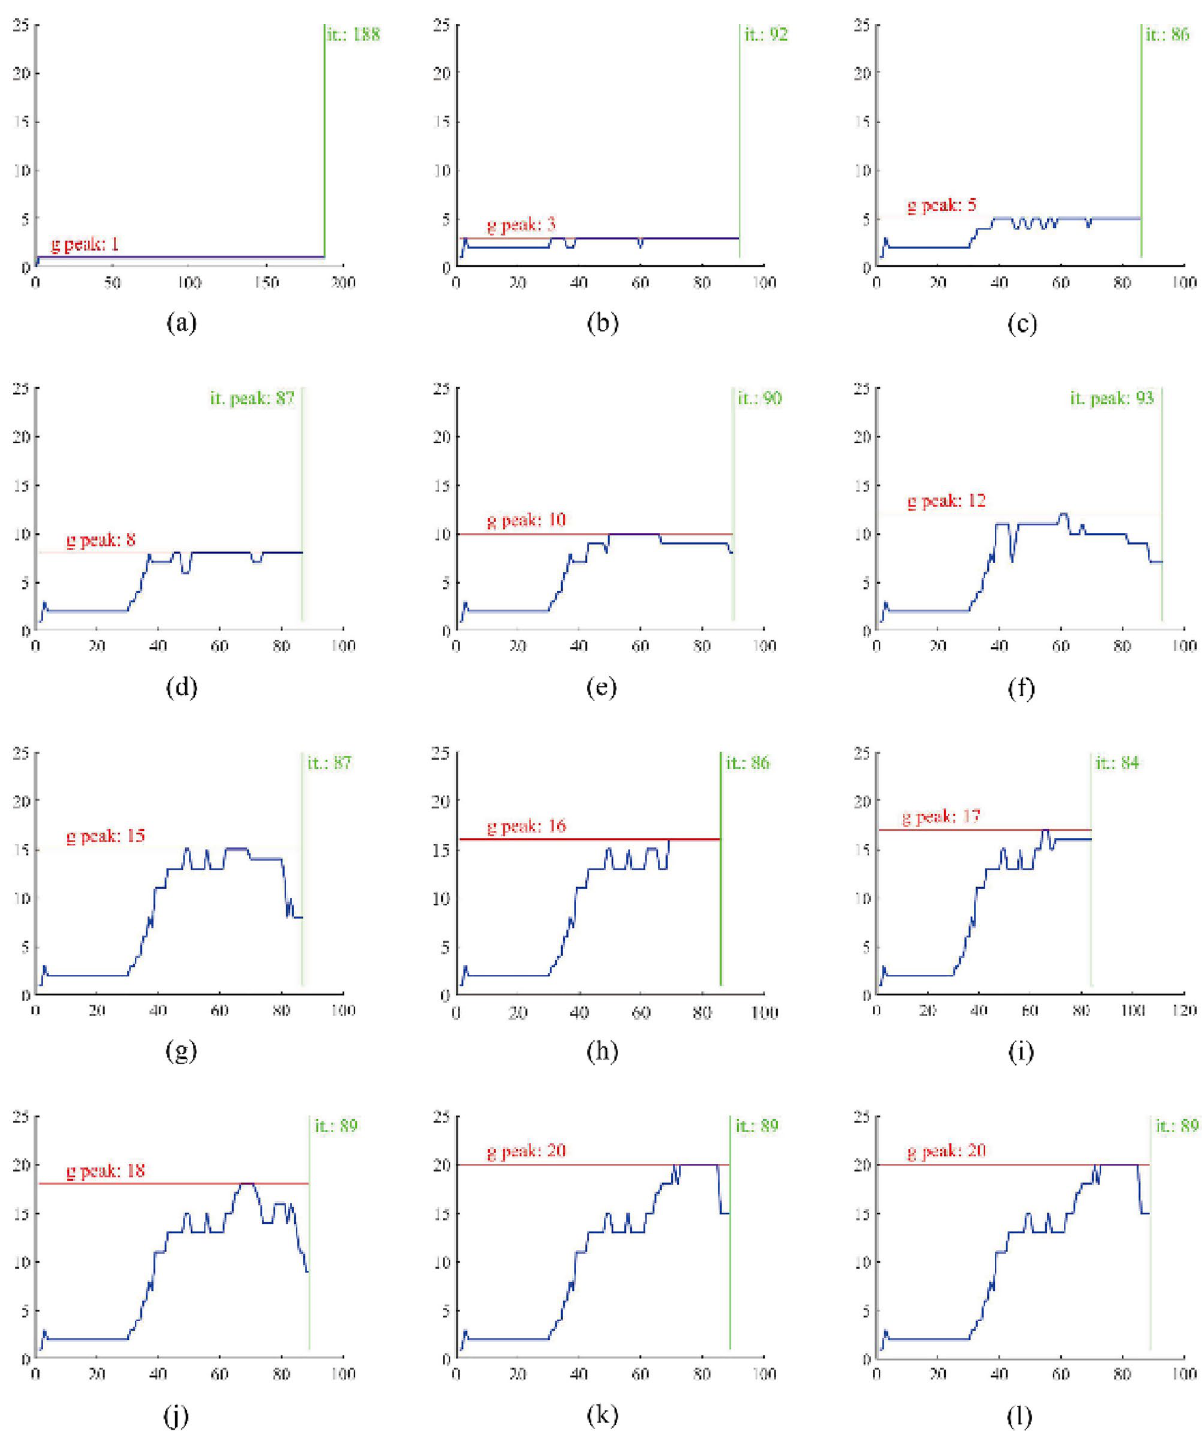
Figure 9. Change in the genus of the structure during the optimization process of the example in Fig. 8. The line marked “g peak” gives the maximum genus of the structure appearing in the optimization process. The line marked “it.” gives the maximum iteration